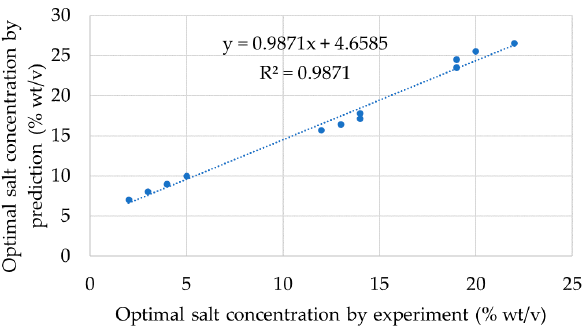
Figure 5. Optimal salt concentrations (S*) from the HLD prediction and the experiment of AAE(6EO4PO) through Excel Solver.